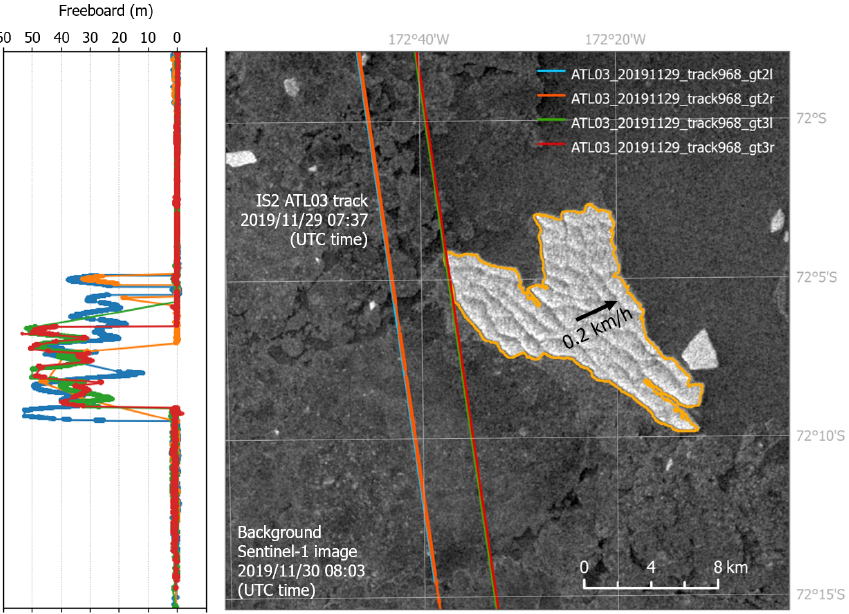
Figure 10. Freeboard measurements from ICESat-2 ATL03 tracks on 29 November 2019, and Sentinel-1 image on 30 November 2019 (about 24h